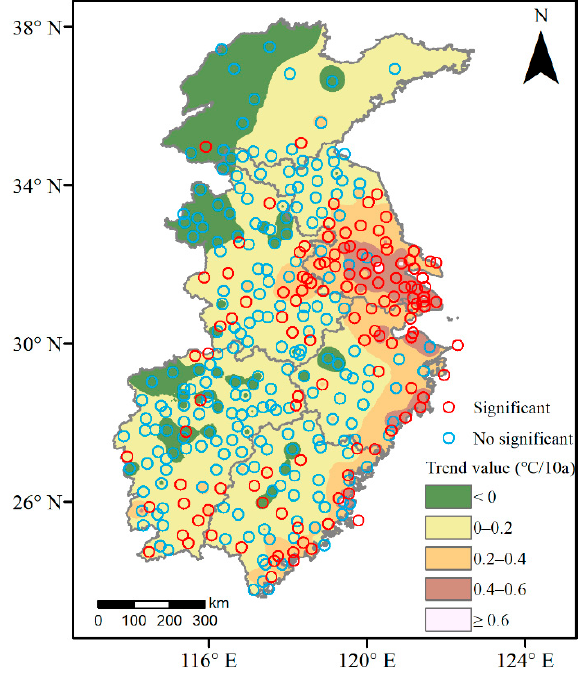
Figure 6. Climate tendency rate and significant variation in East China during the period 1961–2020.